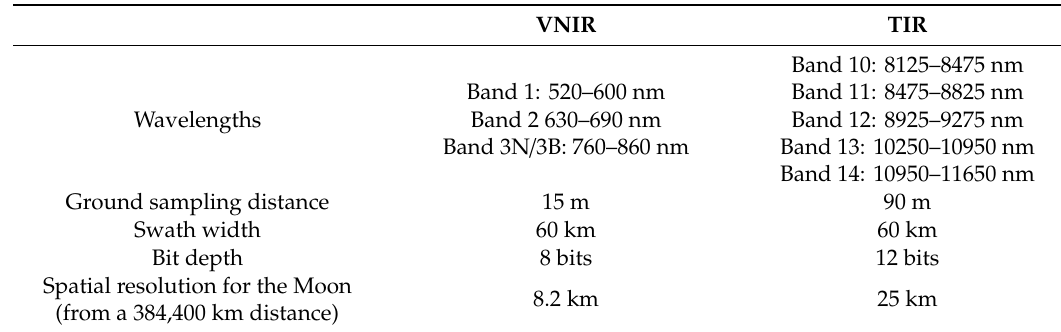
Table 1. Specifications of visible and near infrared (VNIR) and thermal infrared (TIR) bands of Advanced Spaceborne Thermal Emission and Reflection Radiometer (ASTER).